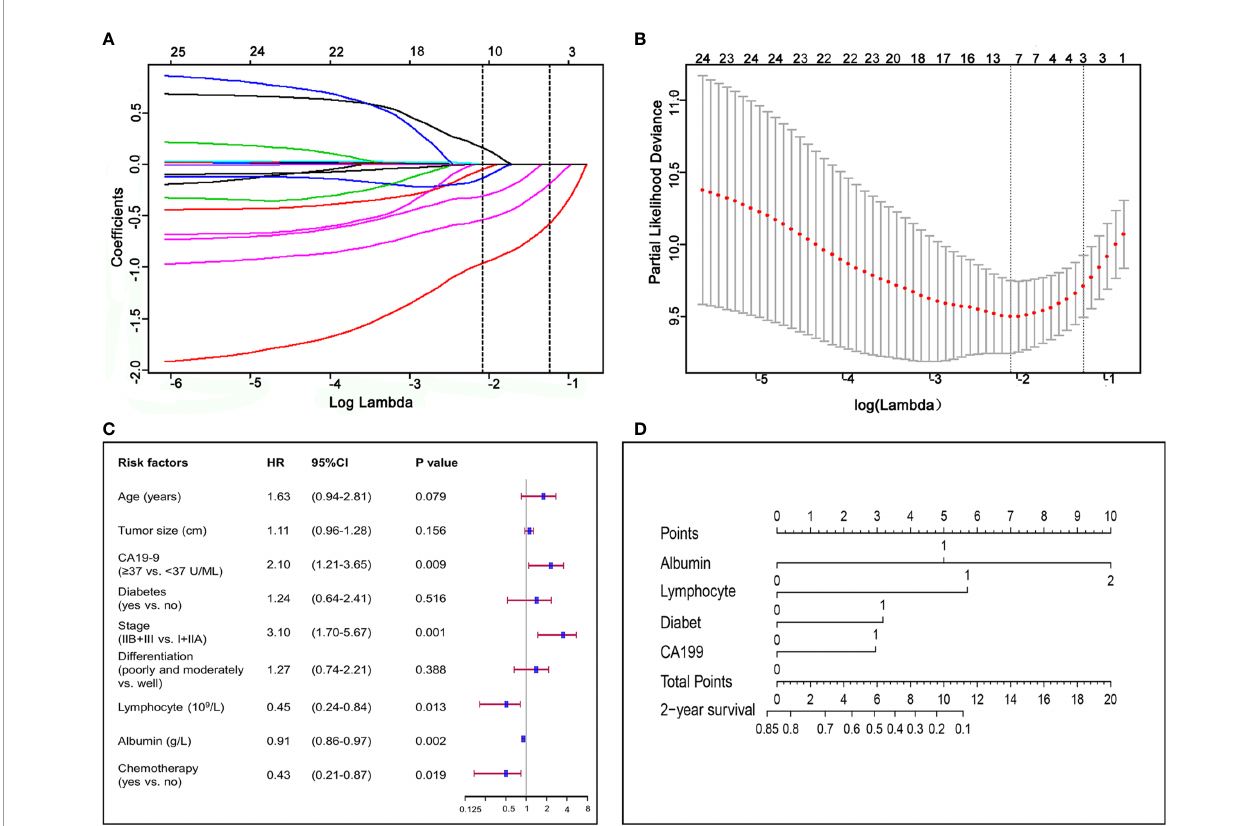
FIGURE 1 | Factors associated with prognosis and construction of a nomogram for pancreatic ductal adenocarcinoma. (A) LASSO coef fi cient pro fi les of the fractions of 17 preoperative indicators and clinicopathological factors associated with pancreatic ductal adenocarcinoma. (B) Tenfold cross-validation for tuning parameter selection in the LASSO model. (C) Forest plot visualizing the HRs of prognostic factors identi fi ed by multivariate COX analysis of the training group. (D) Nomogram for predicting 2-year survival for patients in the training group. The nomogram was established in the training group, with albumin, lymphocyte, diabetes and CA19-9